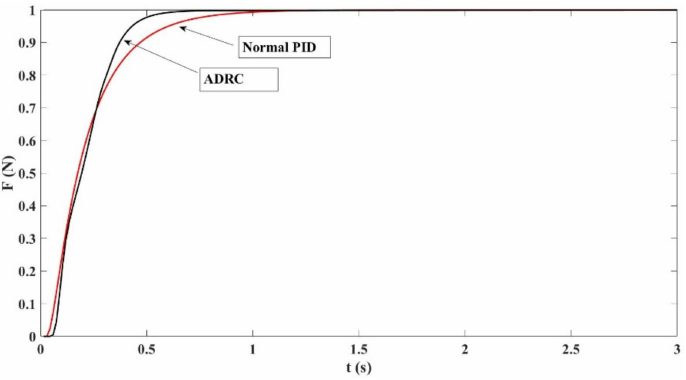
Figure 7. Unit step response of ADRC and